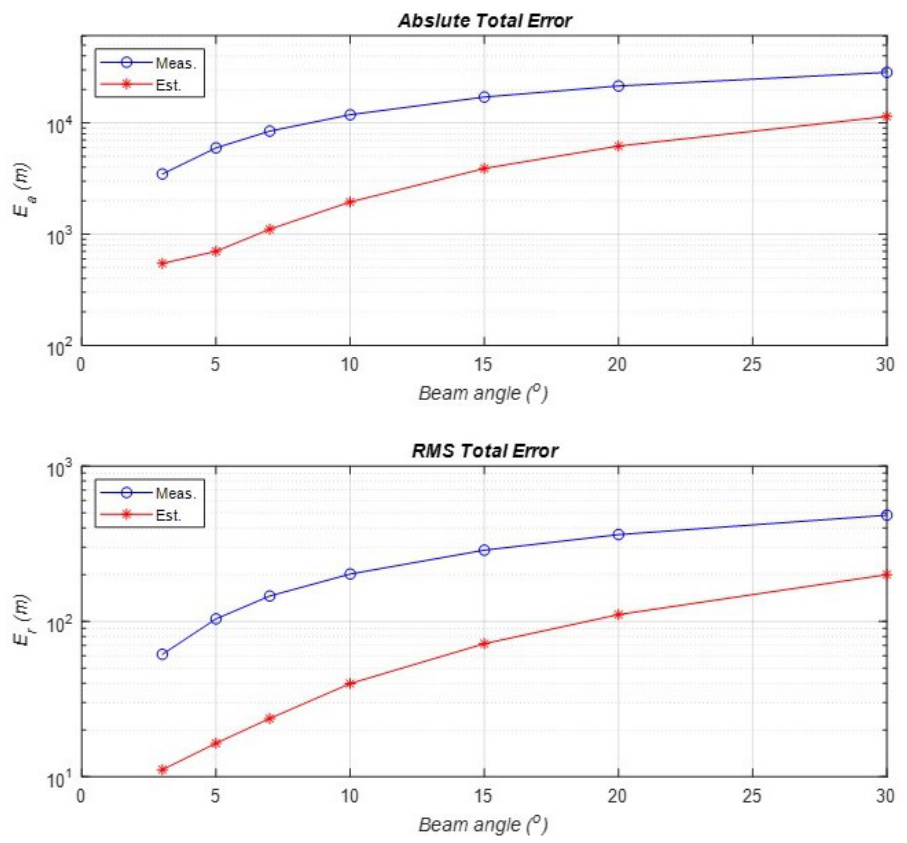
Figure 8. Variation in the absolute and RMS total measured errors (blue lines), and the absolute and RMS total estimated errors (red lines) for different beam angles at a constant grid range without external